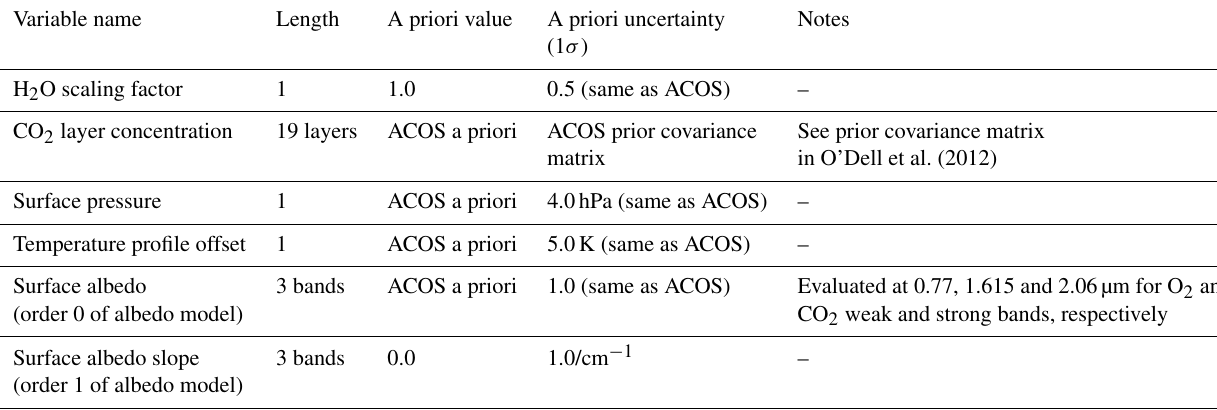
Table 1. 5AI state vector composition for OCO-2 retrievals.